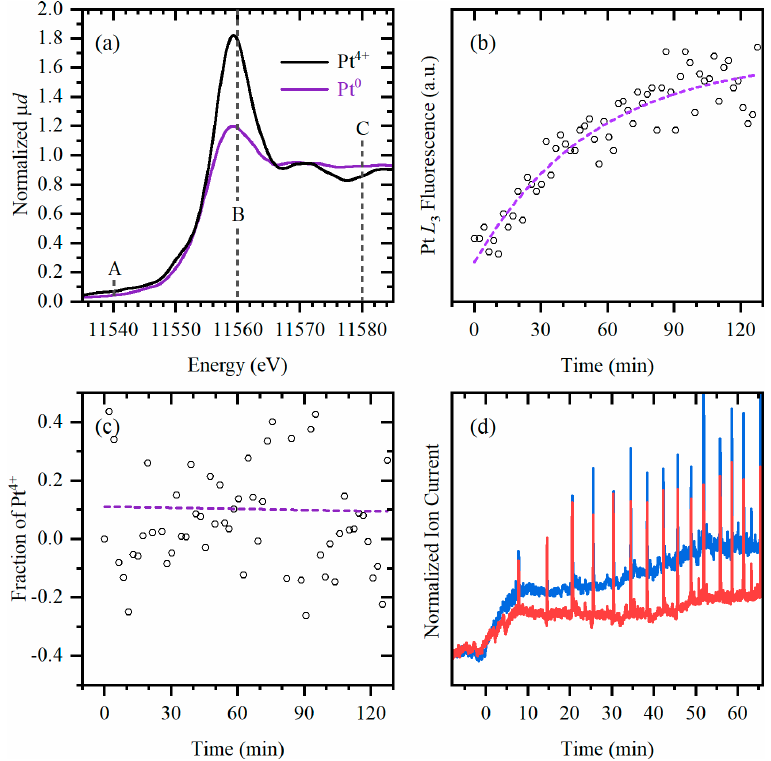
Figure 2. ( a ) Pt L 3 -edge XANES of solid K 2 PtCl 6 (black) and Pt/TiO 2 at the end of in situ photodeposition experiment (purple). The dashed vertical lines highlight the energy points in which the time-resolved fluorescence was collected. ( b ) Evolution of the absolute intensity of the fluorescence Pt signal in points B and C over time during the in situ photodeposition experiment, fitted by an exponential function (purple dashed line). ( c ) Estimation of Pt 4+ fraction based on Equation (1), fitted by a linear function (purple dashed line). ( d ) MS signal of m / Z = 2 (blue) and m / Z = 44 (red) divided by the signal of m / Z = 40 and normalized by area. A second challenge derives from the use of a laboratory source for collecting XAS spectra. A significant amount of time is required to collect a single spectrum compared with that of synchrotron sources, which is not compatible with the time resolution needed to follow the Pt photodeposition process. Therefore, on the basis of the K 2 PtCl 6 reference spectrum, three energy points were chosen (A, B, and C in Figure 2a): before the edge (11540 eV), at the white line (11560 eV), and after the white line (11580 eV). During the in situ Pt photodeposition from the solution onto the TiO 2 support under UV irradiation, the fluorescence signal was continuously collected in only these three points. After 2 h of irradiation, the UV source was switched off, and a complete XANES spectrum was collected in situ (Figure 2b, violet curve). This spectrum is characterized by a significantly reduced intensity of the white line at 11560 eV, with respect to that of K 2 PtCl 6 , and is characteristic of the Pt(0) state.